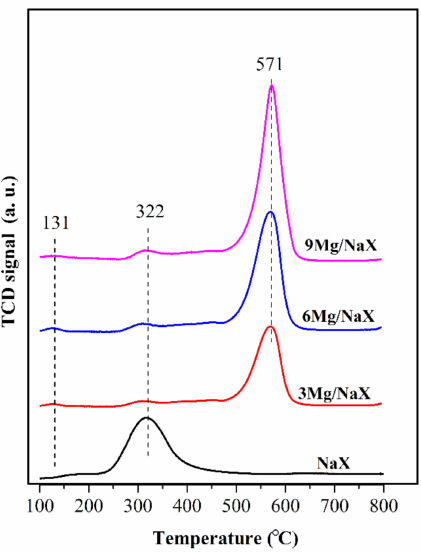
Figure 4. CO 2 -TPD profiles of bare NaX and catalysts with various magnesium